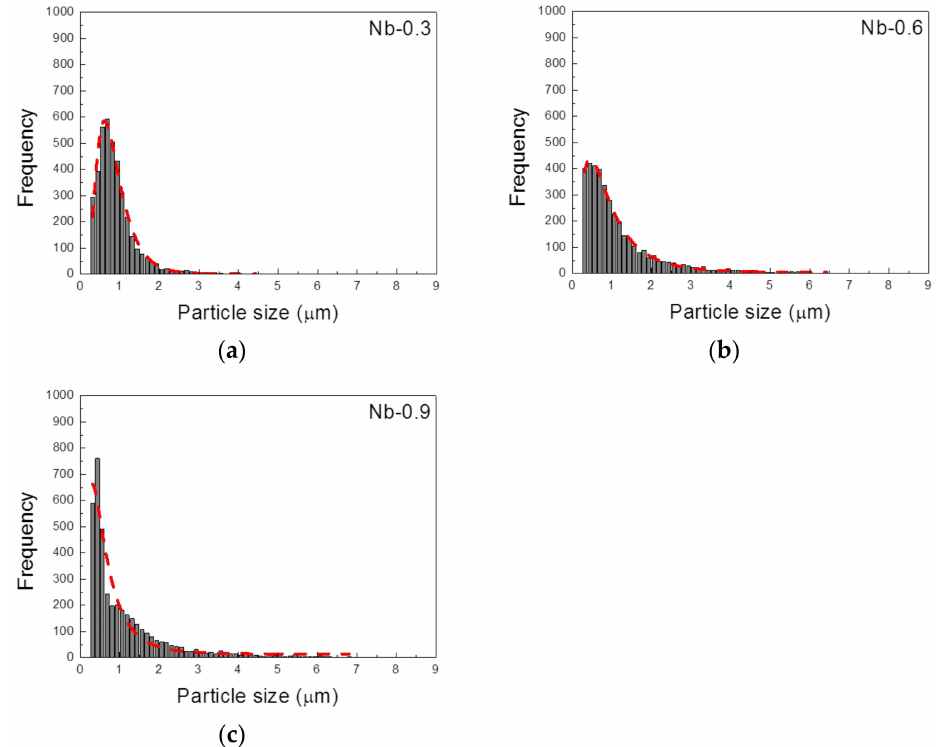
Figure 9. Histograms of precipitate size in 22Cr25NiWCuCo(Nb) steel specimens with different Nb contents after heat treatment at 1200 ◦ C for 6 h: ( a ) Nb-0.3, ( b ) Nb-0.6, and ( c ) Nb-0.9 steel